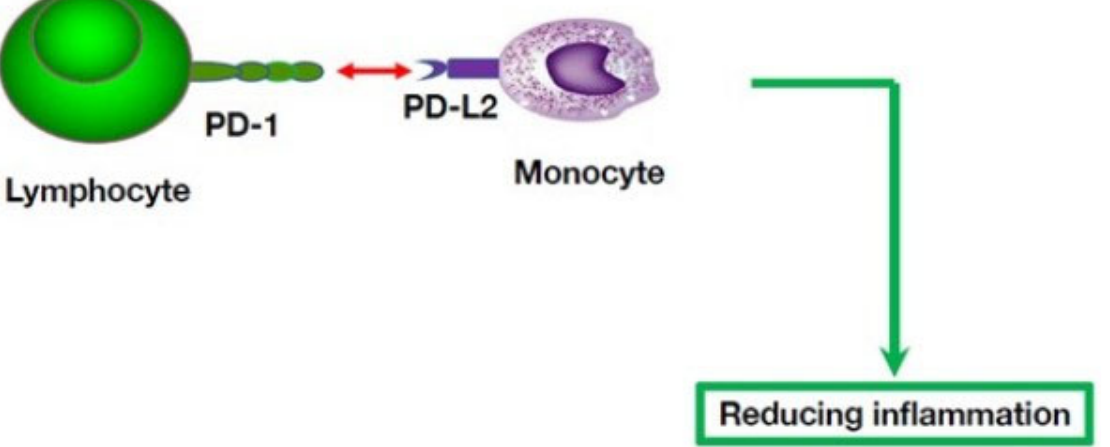
Figure 4. B cell contact-dependent mechanisms modulating innate immunity by inhibitory receptors expressed by B cells. B cells can contact and suppress other effector cells through inhibitory receptors, including PD-1. The immunosuppressive PD-1 receptor is expressed by B lymphocytes, including germinal center B cells and plasma cells [65,66], and its PD-L1 and PD-L2 receptors are expressed by non-lymphoid cells, including monocytes and macrophages. Thus, this pathway represents another regulatory mechanism that enables B cells to impact a key player of innate immunity, i.e., the monocyte.